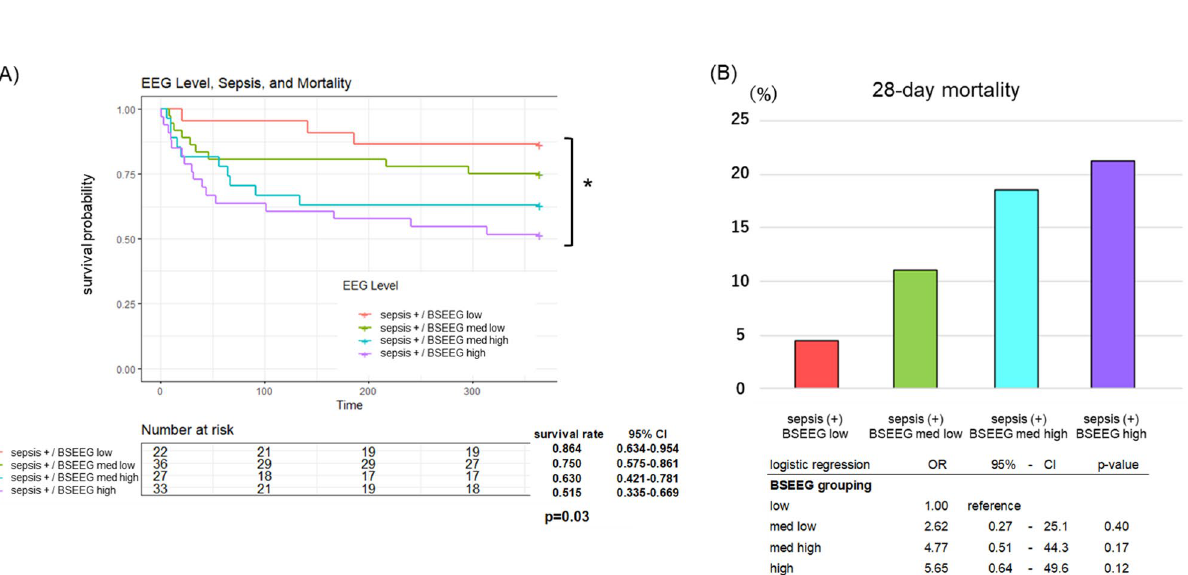
Table 2. Result of the Cox proportional hazard model. CCI Charlson Commobidity Index. * p < 0.05; ** p < 0.01; *** p < 0.001.